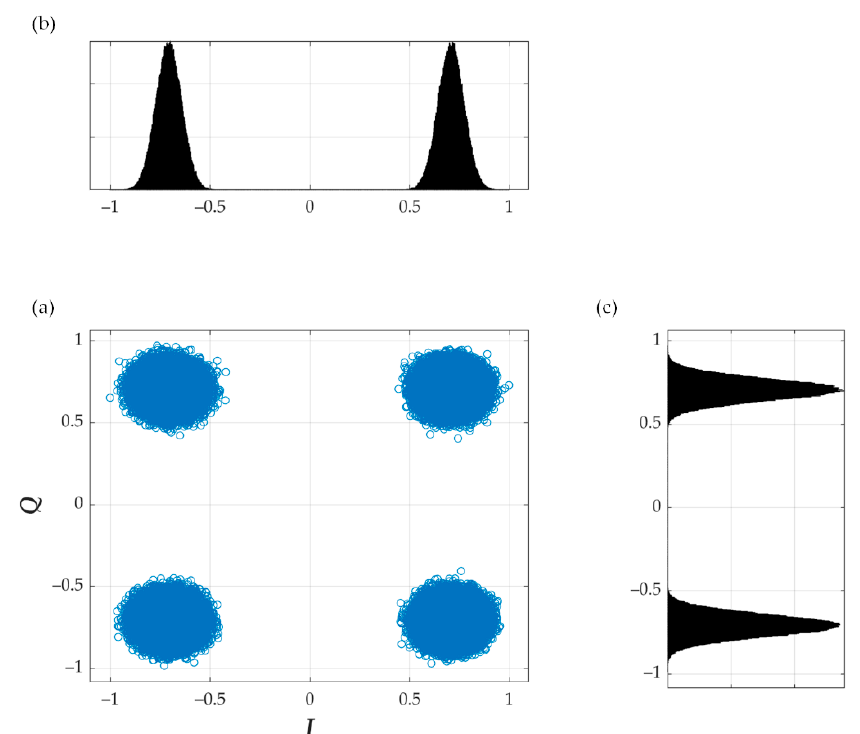
Figure 10. ( a ) Constellation, ( b ) in-phase and ( c ) quadrature histograms for 4 QAM cover and DCM covert channel with M = 4 and for random A m and φ x , E b ⁄ N 0 = 20 dB for cover.